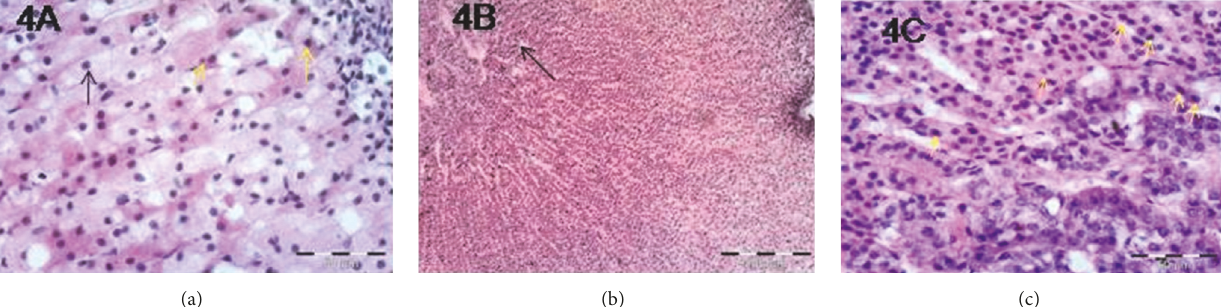
Figure4:PhotomicrographsoftheadrenalglandofgroupIVshowing(a)ZFcellsappearingnearlysimilartothatofcontrol(blackarrow);few cells appear shrunken with hyperacidophilic cytoplasm and pyknotic nuclei (yellow arrows), × 400 (b); congested blood capillaries especially at the area of ZR (arrow), × 100; (c) numerous mitotic figures (arrows) in ZR, × 400.